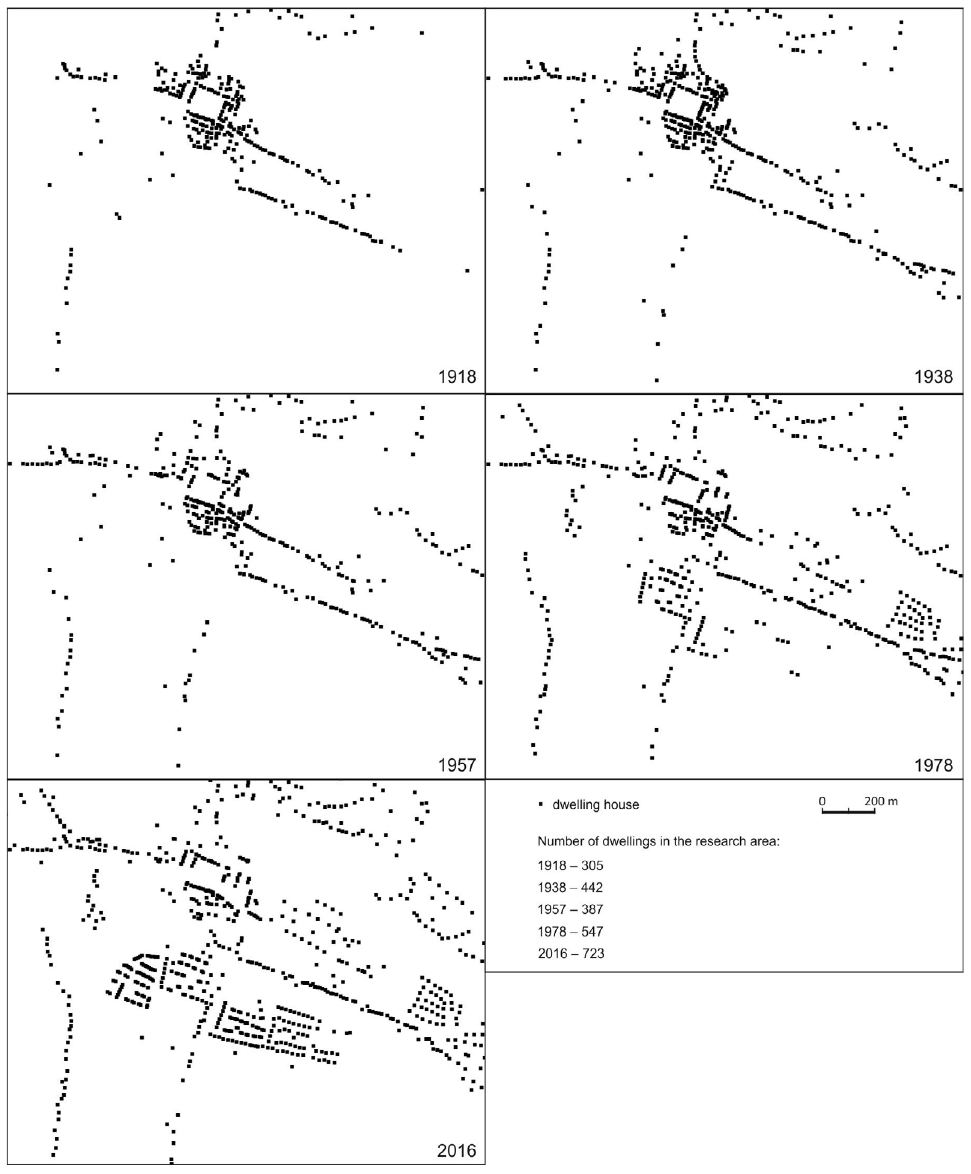
Fig. 3. Dwelling houses in years 1918, 1938, 1957, 1978 and 2016 (J. Kuna